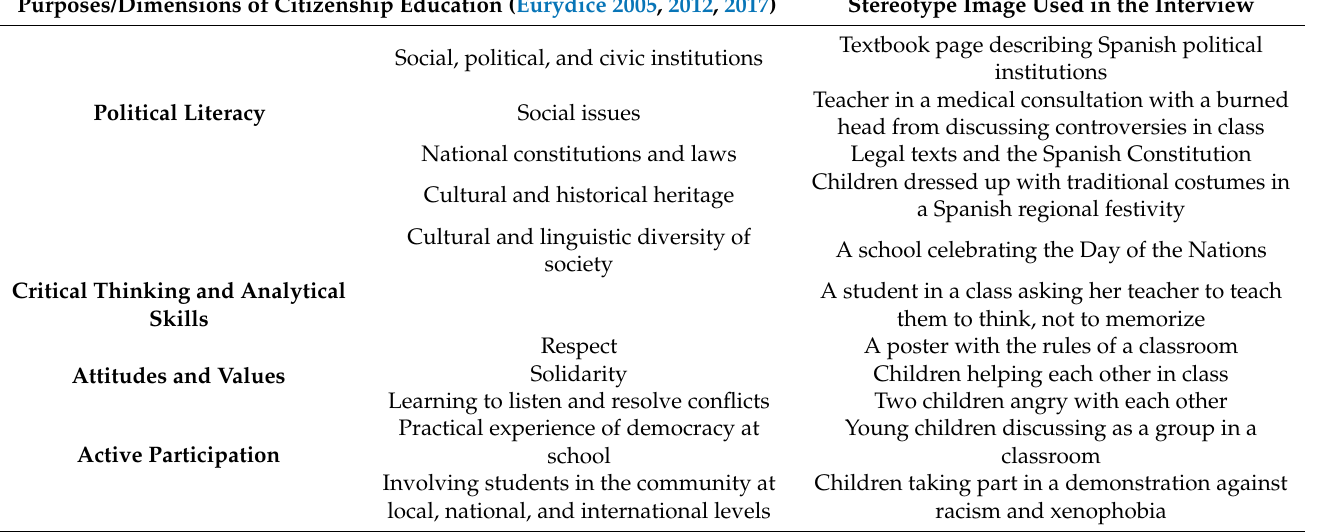
Table 1. Description of the images used in the visual interviews in relation to the different dimensions of CE. Purposes/Dimensions of Citizenship Education (Eurydice 2005, 2012,